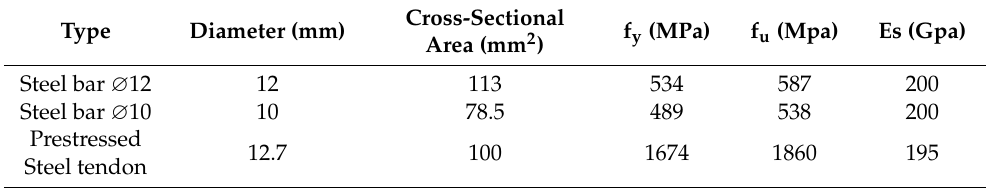
Figure 4. Cross-section of the segmental beam. Table 1. Material properties of steel bars and prestressed steel